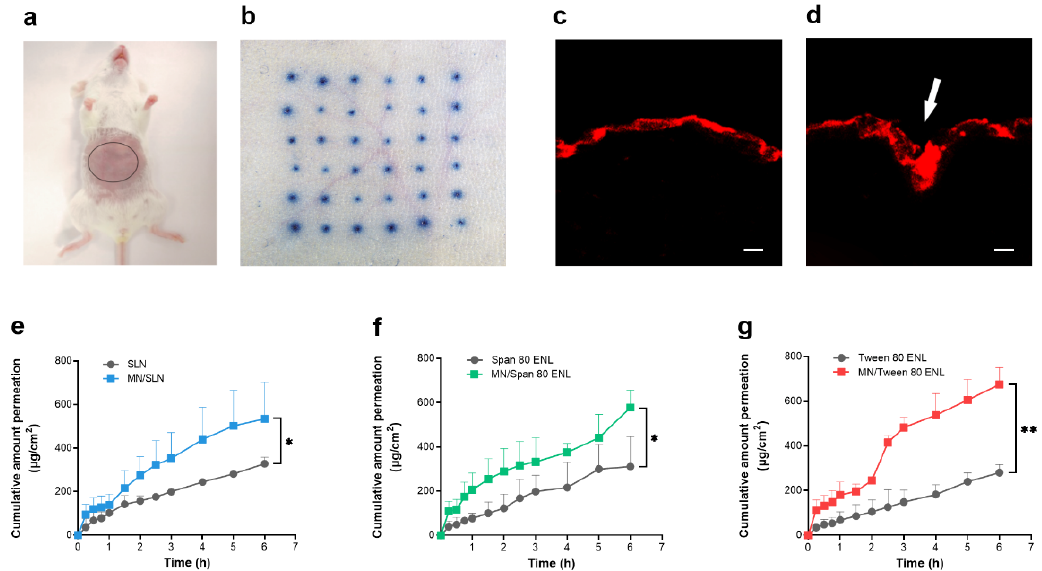
Figure 4. Effective skin penetration of MN and transdermal flux of LidH. Penetration of MN on mice abdominal skin ( a ) with 1% trypan blue staining ( b ). Confocal fluorescence microscopy image showing rhodamine B-stained skin samples with and without MN pretreatment, the white arrow indicates the conduit stained with rhodamine B ( c , d ). Scale bar = 100 µm. In vitro transdermal diffusion tests using: ( e ) SLN with and without MN pretreatment, ( f ) Span 80 ENL with and without MN pretreatment, and ( g ) Tween 80 ENL with and without MN pretreatment. Points represent mean ± SD, n = 3. *: p < 0.05, **: p < 0.01; Student’s t -test. Abbreviations: ENL, elastic nano-liposome; LidH, lidocaine hydrochloride; MN, microneedle; SLN, solid lipid nanoparticle.